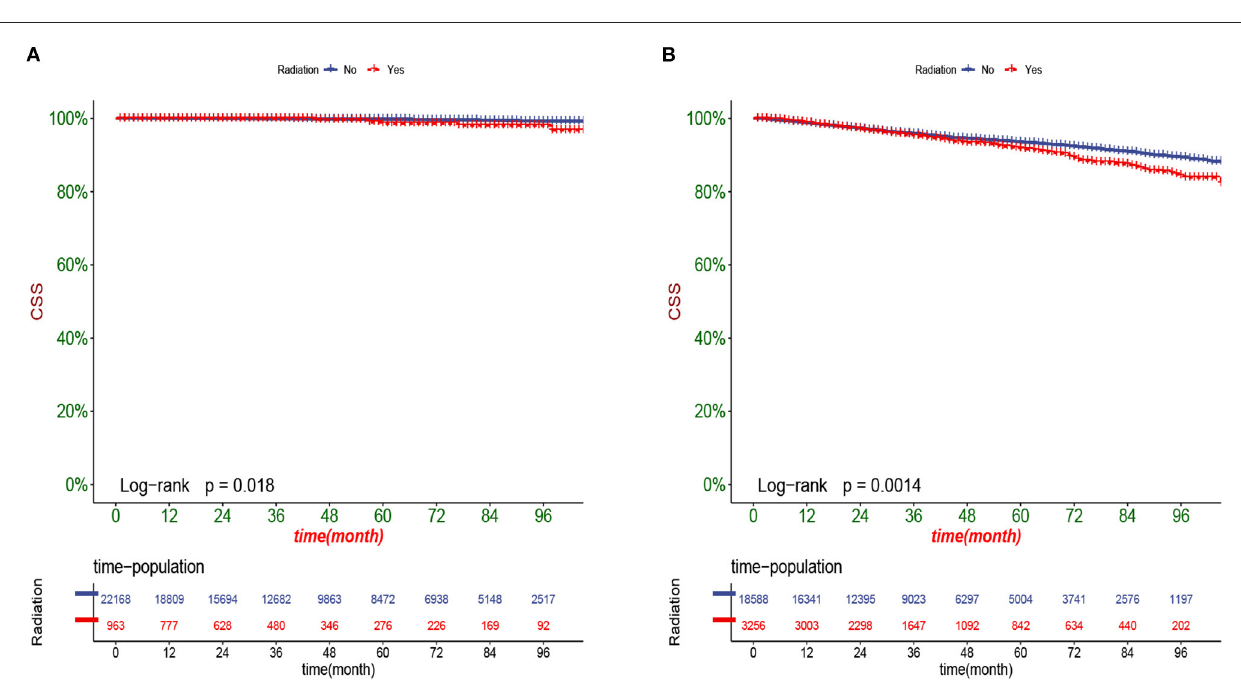
have distant metastasis and have a worse prognosis. At the same time, the small number of people receiving chemotherapy results in biased